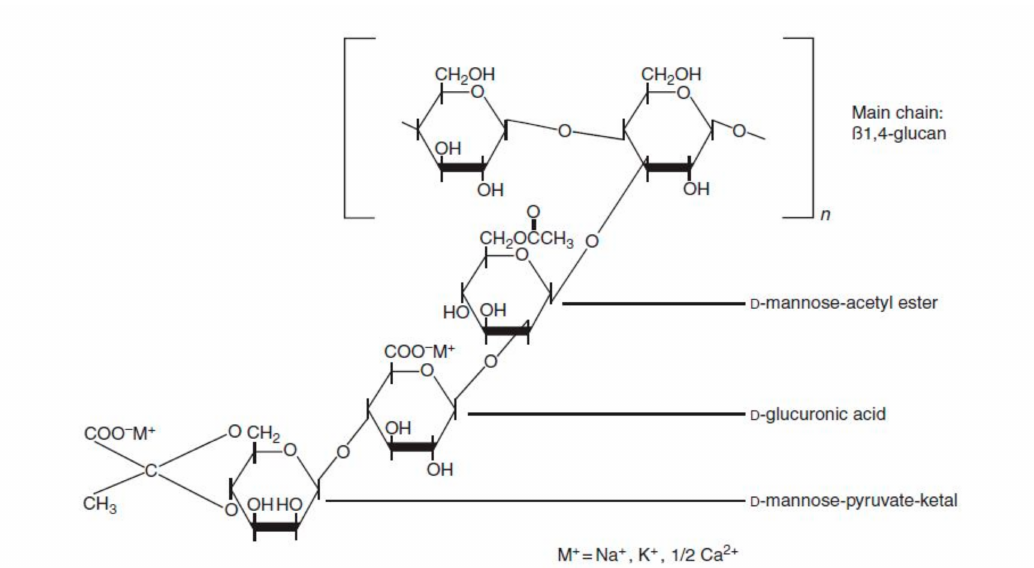
Figure 3. Chemical structure of XG showing both D-Mannose and D-glucuronic acid units linked to the backbone of the glucose, while (M + ) is the cation binding sites. Reprinted from [24]. Copyright